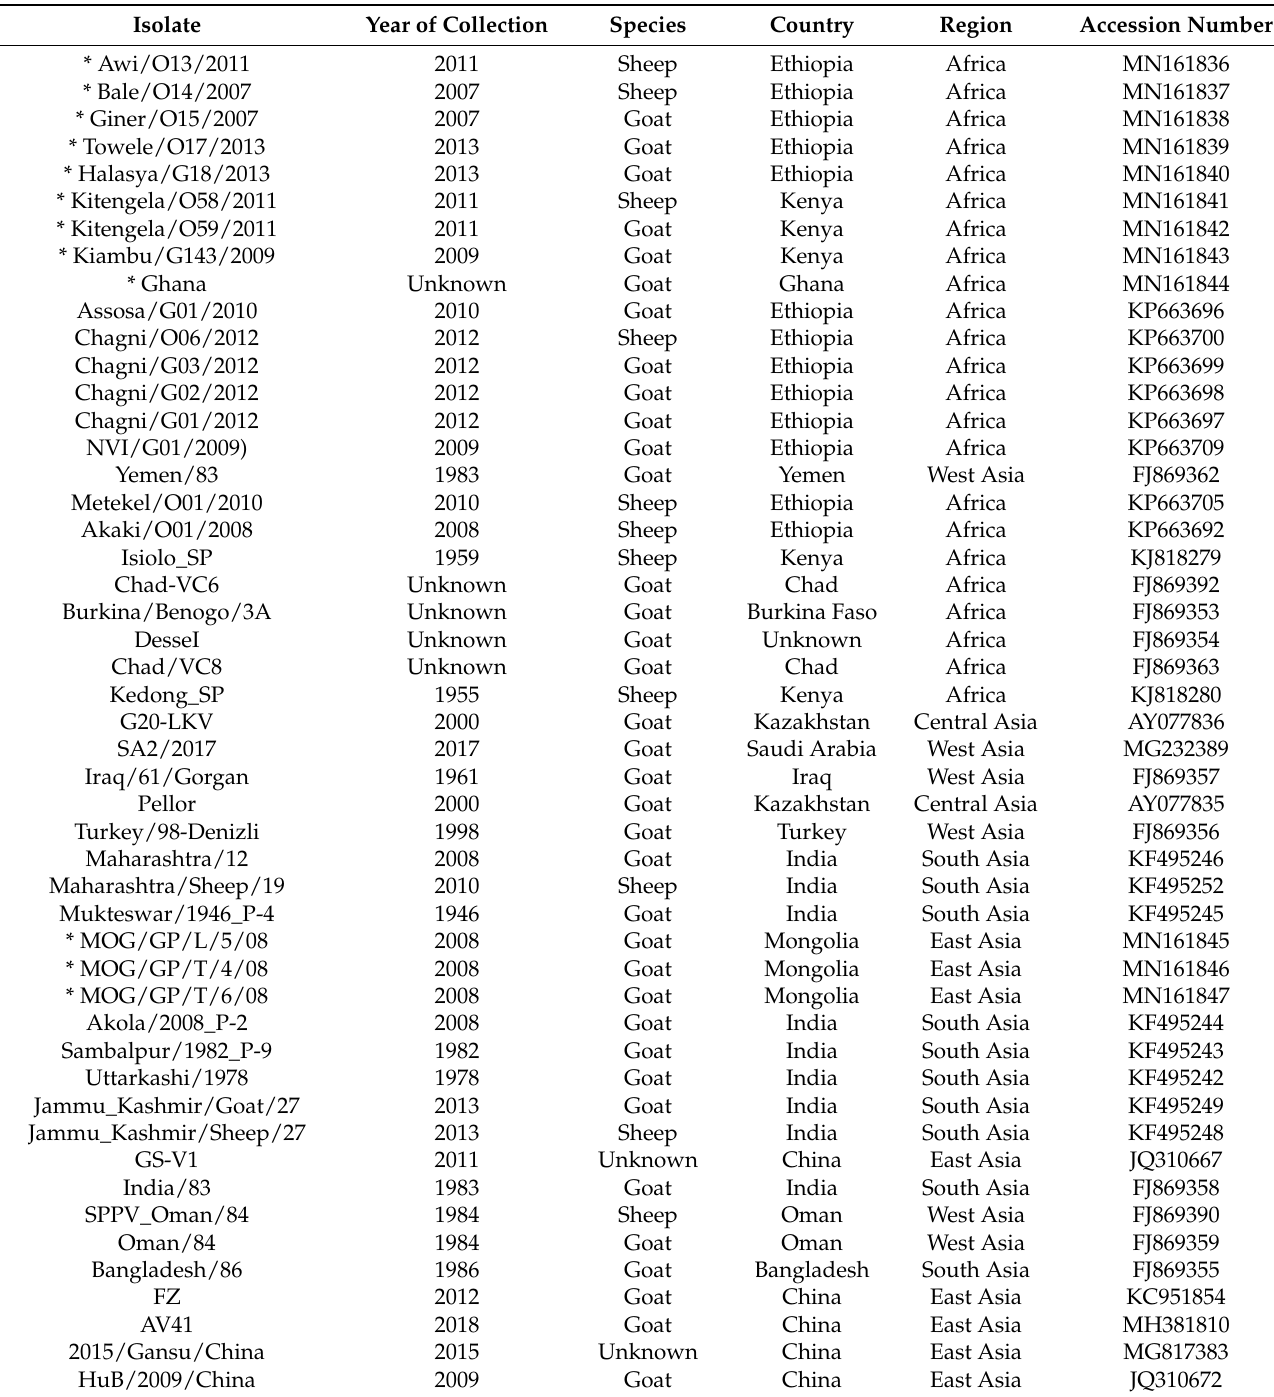
Table 1. Goatpox viruses used in the comparative